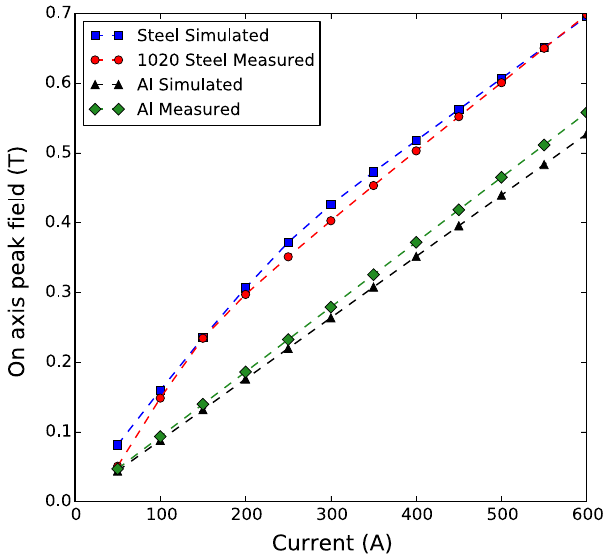
FIG. 23. Excitation curves of the 20-mm-period short prototype HSCU magnets.